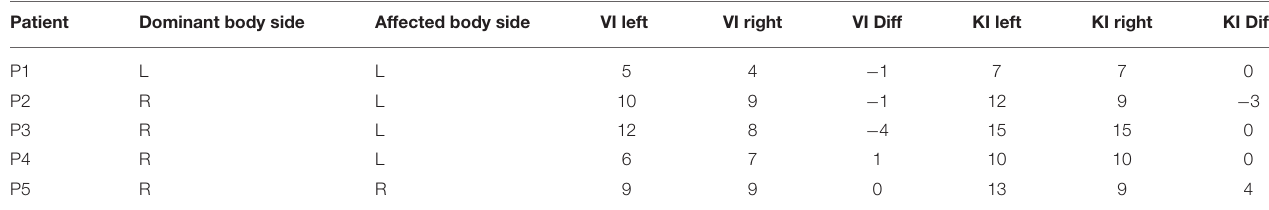
TABLE 6 | Patients’ side of dominance and stroke, self-rated motor imagery sum scores for visual imagery (VI), and kinesthetic imagery (KI) for the left and right upper limb (out of 15 possible points, with higher values denoting higher imagery capacity).